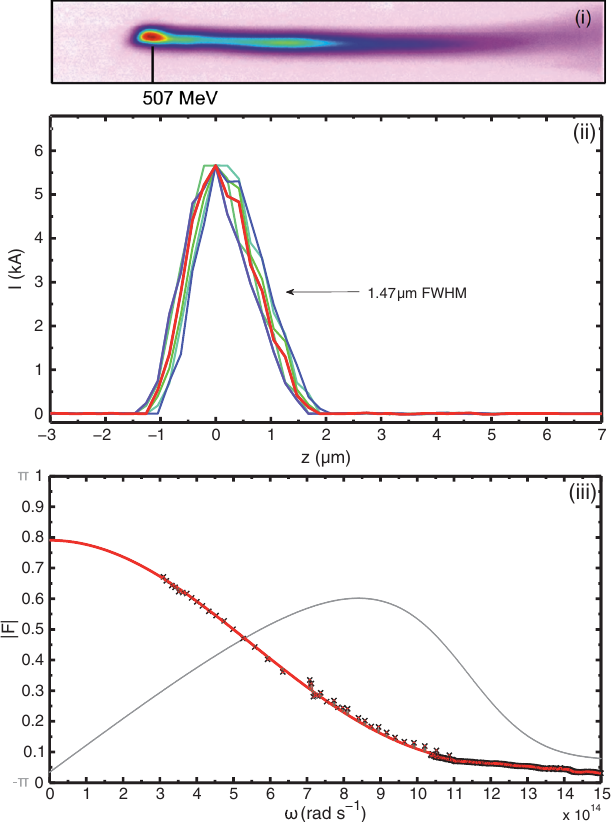
FIG. 8. Reconstruction of longitudinal bunch profile from experimentally measured CTR spectrum: (i) image of Lanex screen at the exit of the electron spectrometer; (ii) ten recon- structed profiles, the most representative of which is colored red; (iii) measured spectrum (thick black line, black crosses) and reconstructed spectra (colored lines), including retrieved phase of most representative profile (gray dots). Data for Shot 1930: ¼ 4 : 0 (cid:7) 10 18 cm (cid:2) 3 ); L cell ¼ 6mm ; E peak ¼ P ¼ 83 mbar ( n e 507 (cid:3) 92 MeV (FWHM); Q 8 : 7 pC ; Q 34 : 6 pC peak ¼ total ¼